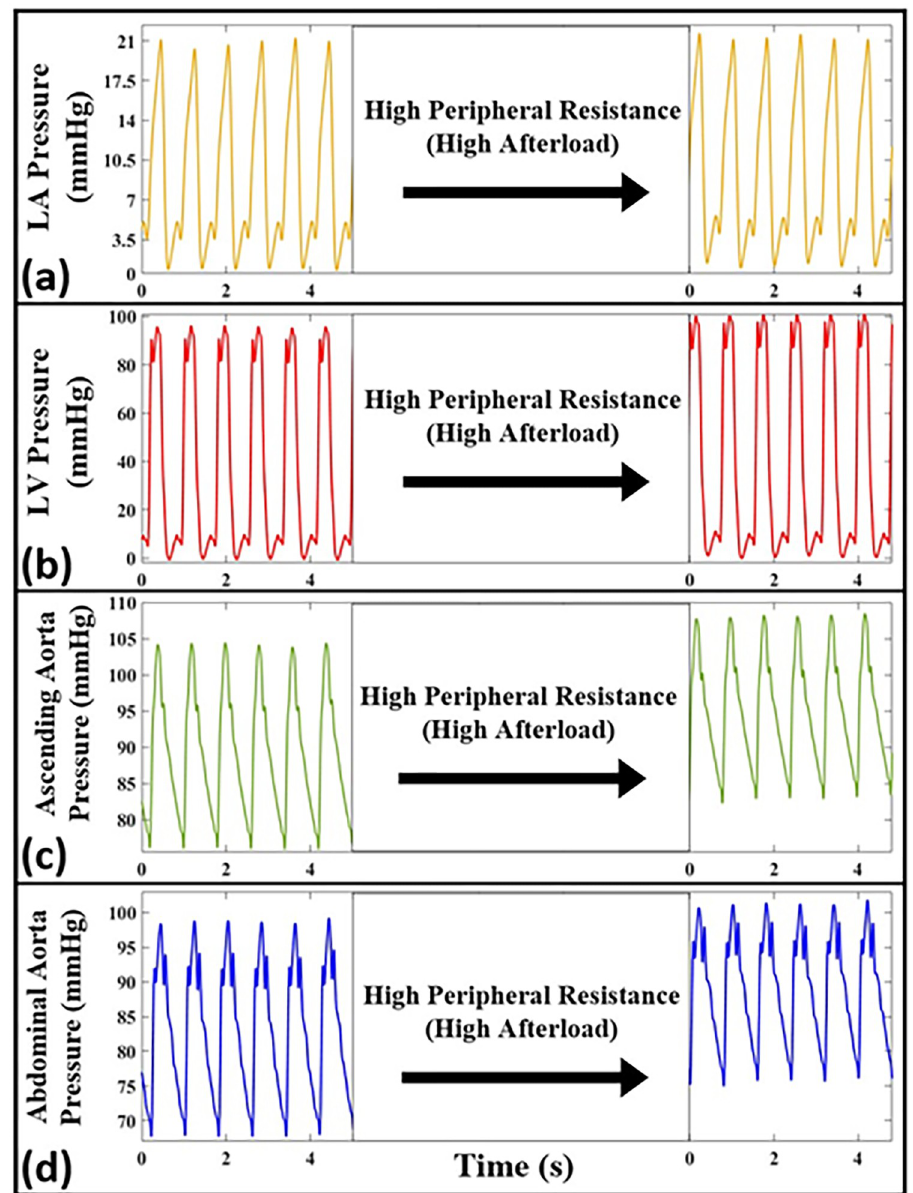
Fig 11. The measured pressure waveforms for normal and high peripheral resistance (i.e., high afterload) conditions at different anatomical sites including (a) the left atrium, (b) the left ventricle, (c) the ascending aorta, and (d) the abdominal aorta. Waveforms are produced from Aorta-3 and correspond to HR = 75 bpm. The data of this figure is collected without pausing the pump to show the immediate dynamic changes of the setup (we only showed the oscillatory steady state of each phase for